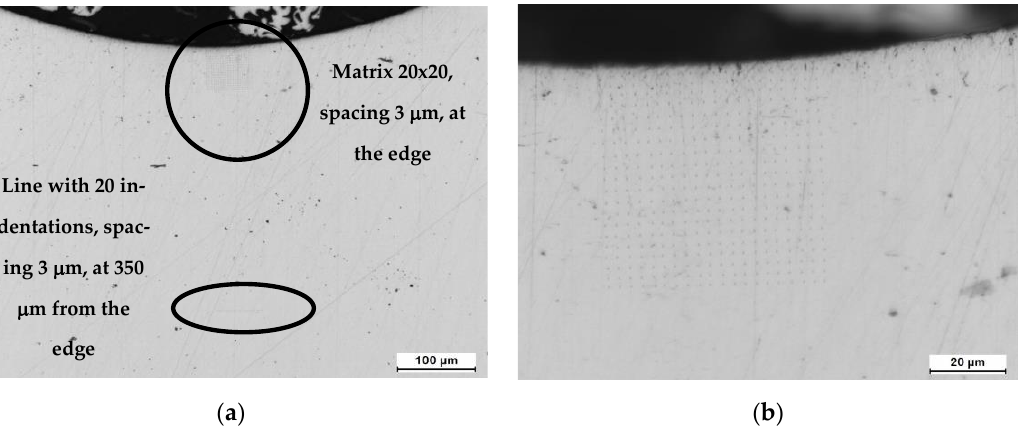
Figure 3. ( a ) Optical microscopy image showing the matrix of 20 × 20 indentations performed close to the surface and the line of 20 indentations performed at 350 µ m from the surface. ( b ) Detail of the matrix of indentations starting from the surface with first line aiming at 3 μm from the surface.